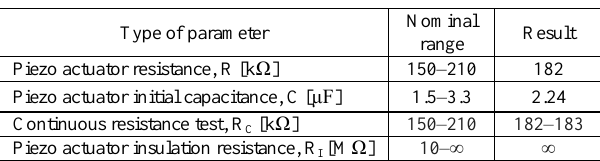
Table 1. Results of the electric tests